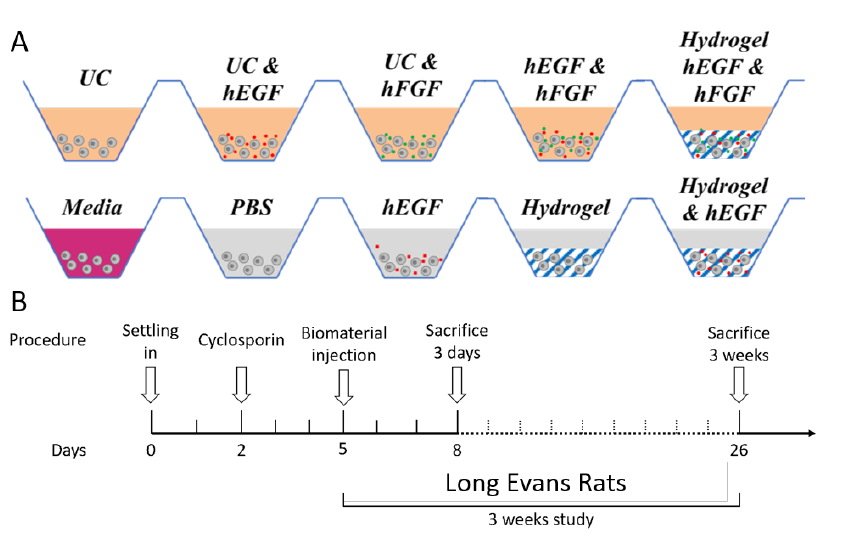
Figure 2. Experimental design to test the effect of Gtn-HPA and HA-Tyr on hRPCs. ( A ) hRPCs were cultured for 14 days in different conditions: in PBS, Ultraculture base medium (UC), in media including growth factors, with hEGF, with hFGF, in hydrogels. hRPCs cultured for 14 days in different media and tissue culture were then analyzed for their phenotype with flow cytometry and immunocytochemistry. ( B ) Encapsulated hRPCs were injected in the subretinal space of Long–Evans rats for a 3-week study.